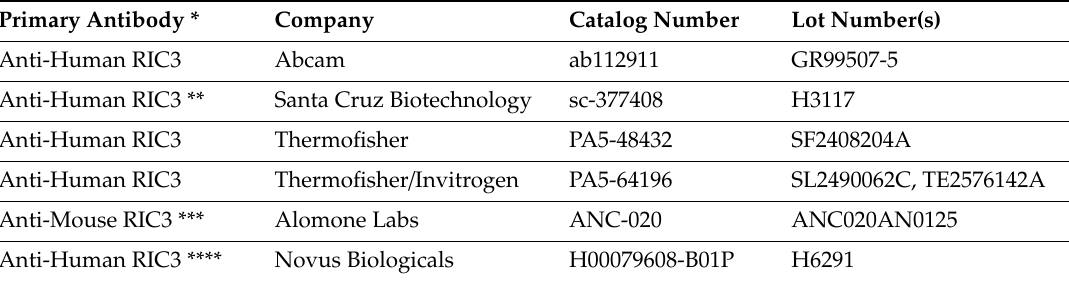
Table 1. RIC3 antibodies used in this